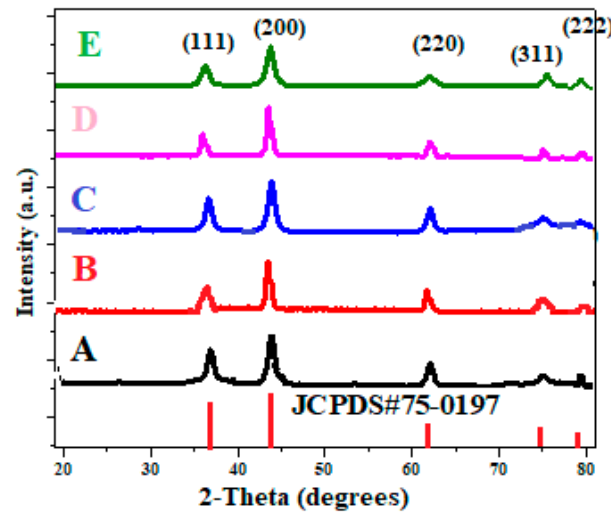
Figure 3. XRD pattern of A–E samples. Table 1. Crystallite size calculated using X-ray di ff